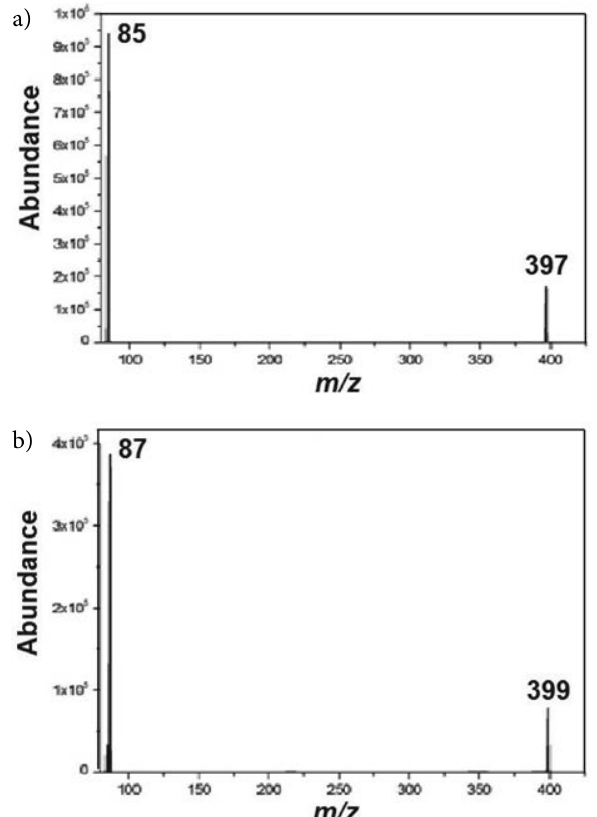
Figure 3 . CID mass spectra of (a) [ 85 Rb(C 24 H 24 )] + and (b) [ 87 Rb(C 24 H 24 )] + ions obtained with nitrogen (1 × 10 –2 mbar) at col- lision energy of 15 eV (laboratory